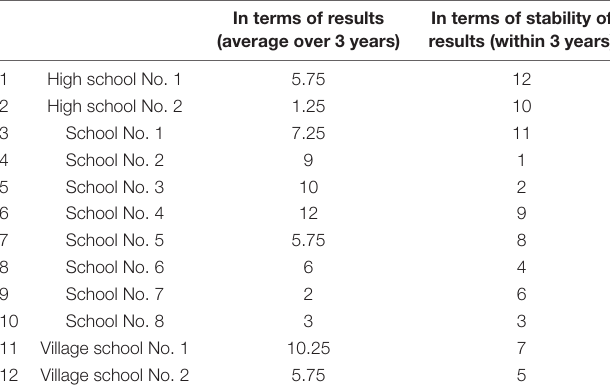
TABLE 1 | Schools’ position in terms of academic performance and stability of